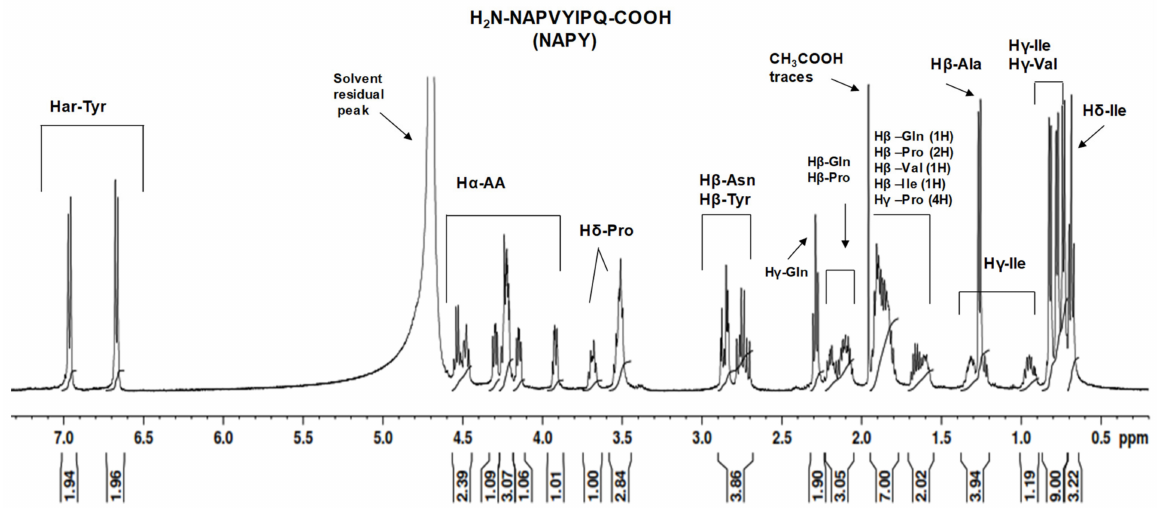
Figure 5. 1 H-NMR spectrum of NAPY peptide dissolved in D 2 O solvent.